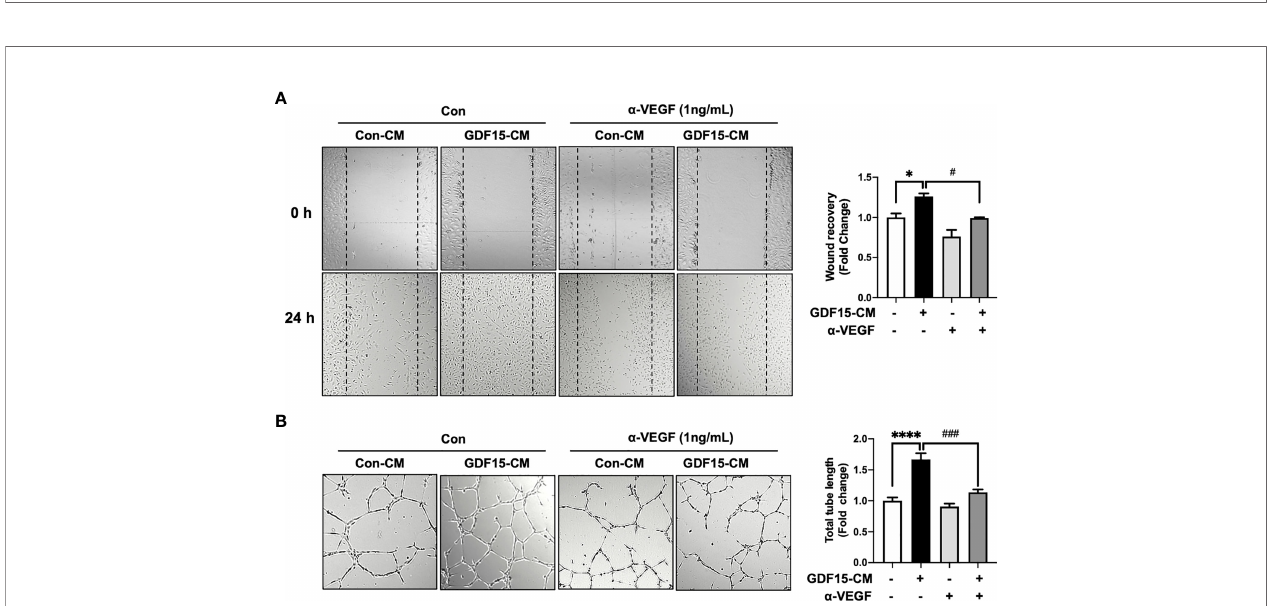
FIGURE 5 | Anti-VEGF antibody blocks GDF15 mediated angiogenesis. (A) Wound healing assay was performed using human brain microvascular endothelial cells (HBMVECs) in the absence/presence of anti-VEGF antibody. The day before the experiment, HBMVECs were seeded in 12-well plates (1.5 × 10 5 /well). The monolayer was scratched to introduce a wound and cells were cultured with control conditioned medium (Con-CM; conditioned medium from HBMVECs) or GDF15-CM HBMVECs (conditioned medium from rhGDF15-stimulated HBMVECs) with added control antibody or a -VEGF (1 ng/mL each). The wounded areas were photographed at 0 h and 24 h and the cell migration as percent mean distance migration was assessed. (B) Representative photographs of tube formation assay. HBMVECs (1.5 × 10 5 cells) were incubated on Matrigel matrix for 12 h with Con-CM or GDF15-CM in the presence or absence of a -VEGF (1 ng/mL). The tube length was measured using ImageJ angiogenesis analyzer (signi fi cance was compared with the group Con-CM in the absence of a -VEGF). Data are presented as the mean ± standard error (* p < 0.01 and **** p < 0.001 compared with the non-treated CM control; # p < 0.05 and ### p < 0.001 compared with rhGDF15- CM